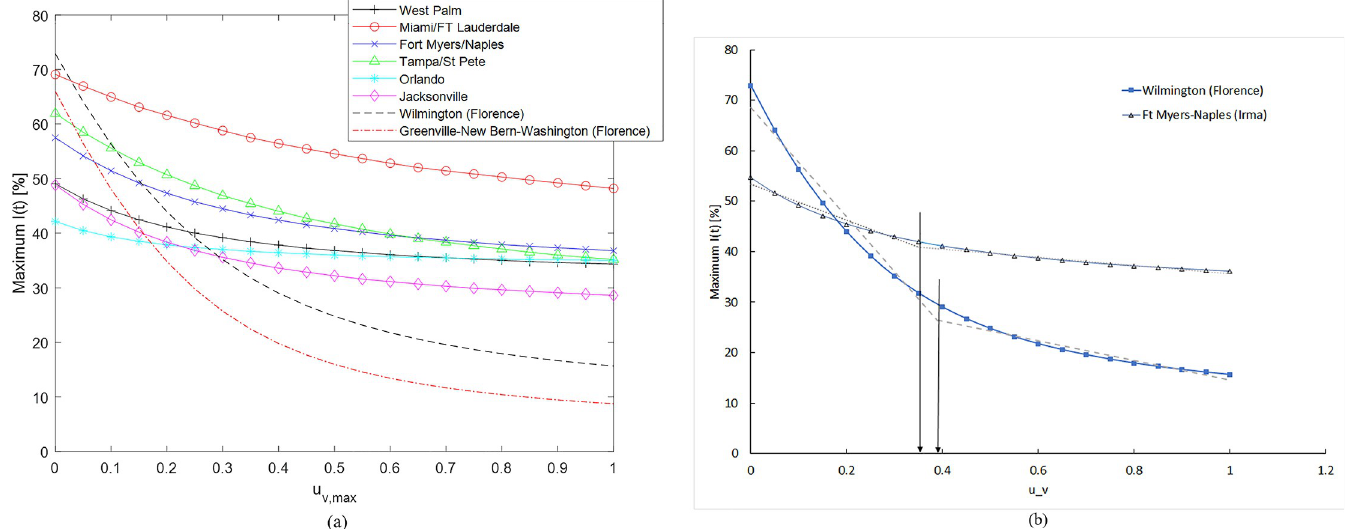
Fig 9. (a). Maximum number of empty fuel stations, I(t), for u v,max ranging from 0 to 1. (b). Bilinear Interpolation of Wilmington and Ft Myers-Naples to determine the optimal u v,max . during Hurricanes Florence and